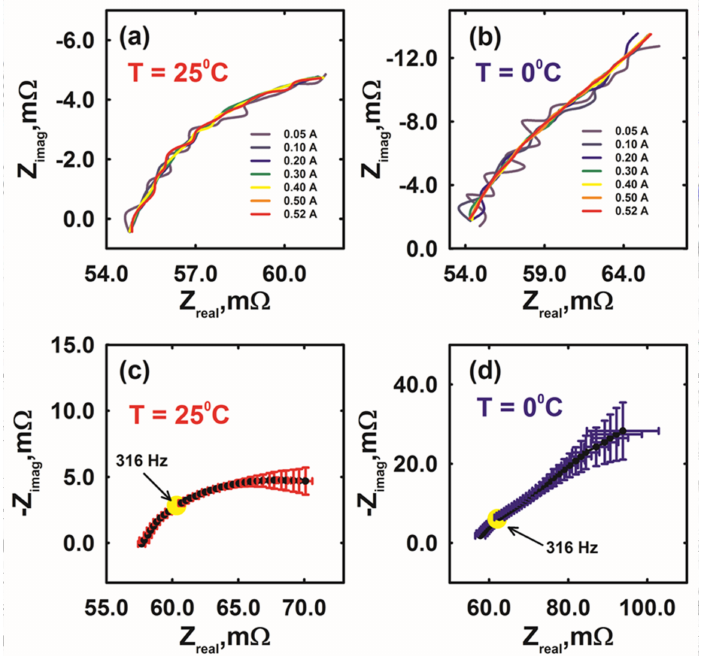
Figure 3. Representative EIS responses to various current amplitude perturbations for cells at 50% SOC (discharged 1.3 Ah) at ( a ) 25 ◦ C and ( b ) 0 ◦ C shown between 1000–100 Hz. Representative average impedance and variance (shown as error bars) for EIS collected at 10% DOD increments from 100–10% at temperatures ( c ) 25 ◦ C and ( d ) 0 ◦ C. Close inspection of the impedance shows a minimum variance in both real and imaginary components at 316 Hz identified by yellow circles in ( c , d